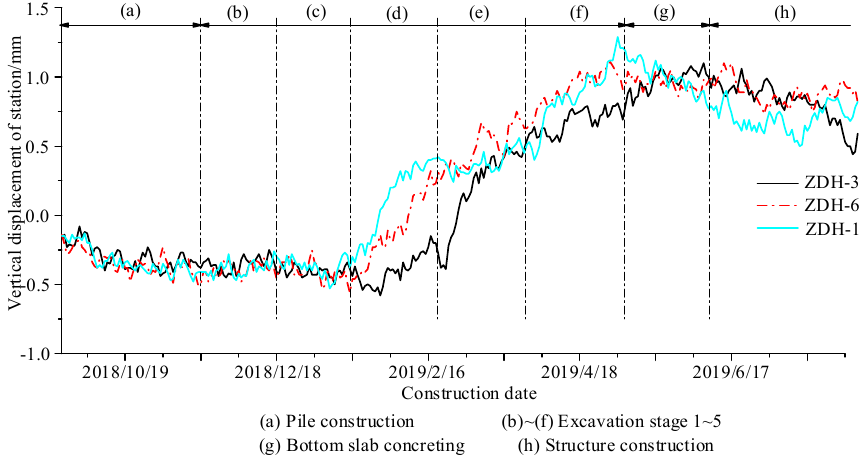
Figure 9. Vertical displacement time − history curve of the station structure.